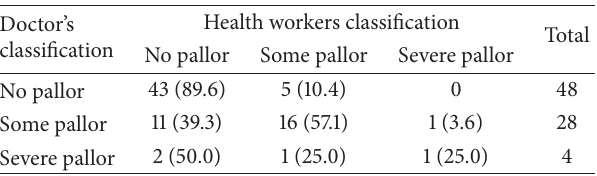
Table 2: Interrater agreement among doctor and health worker to diagnose palmar